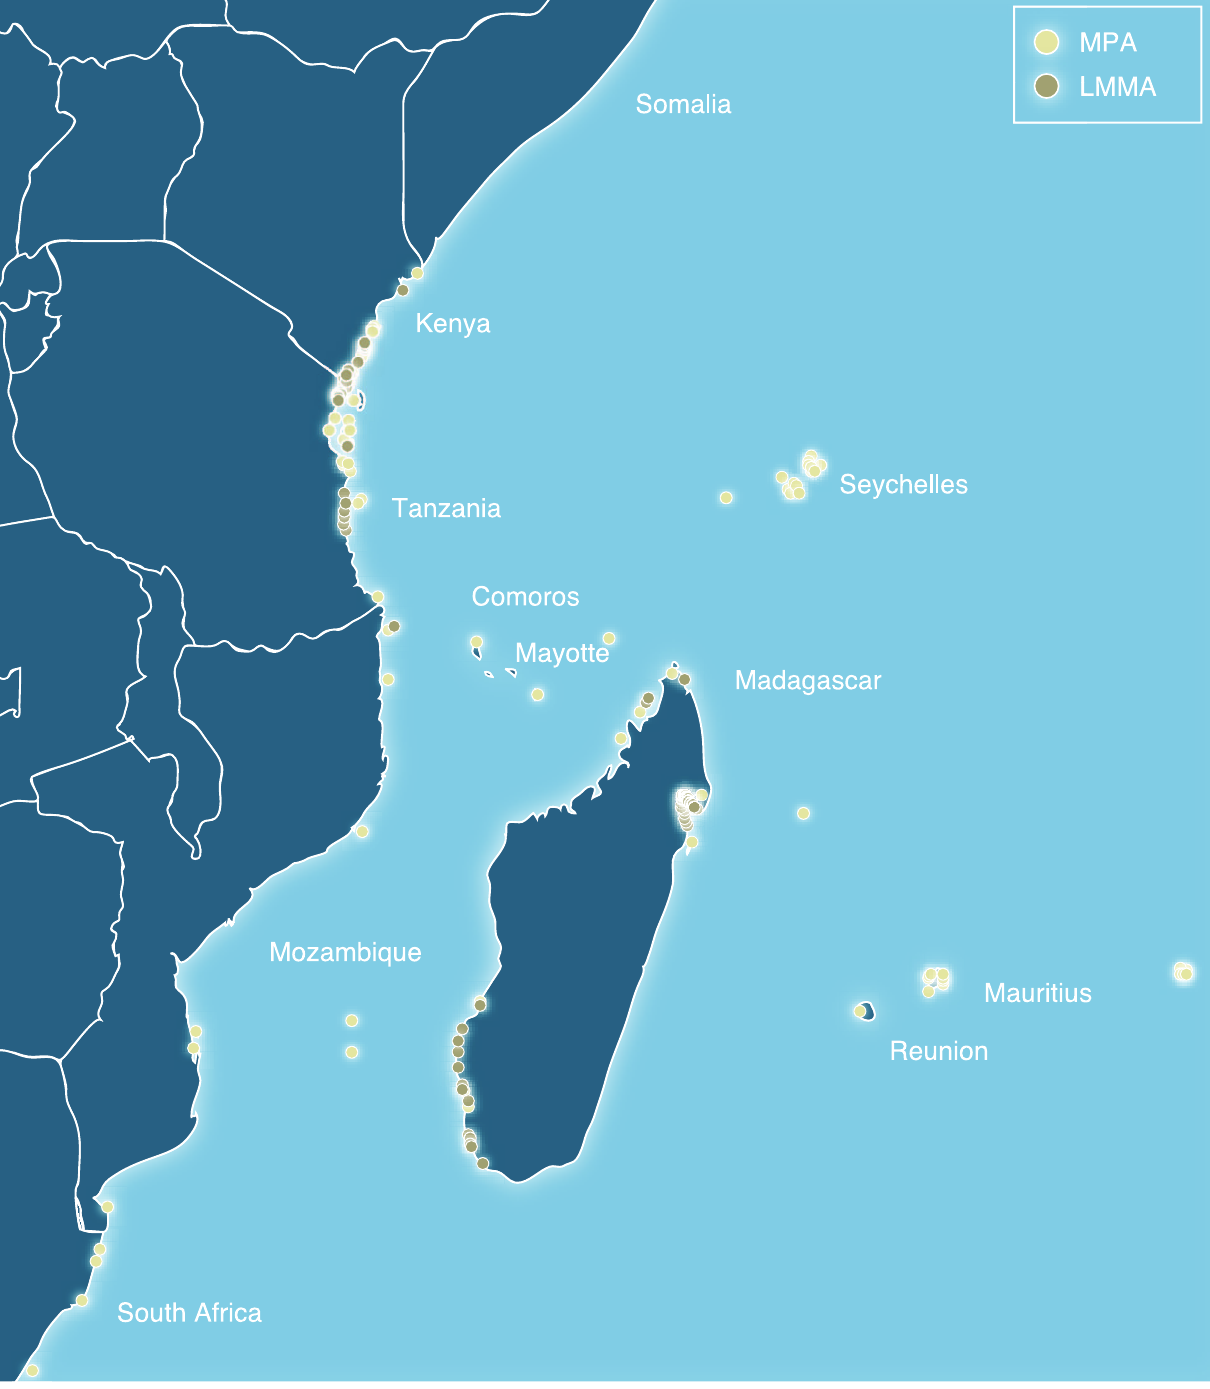
of the world’s seven marine turtle species [50–52].